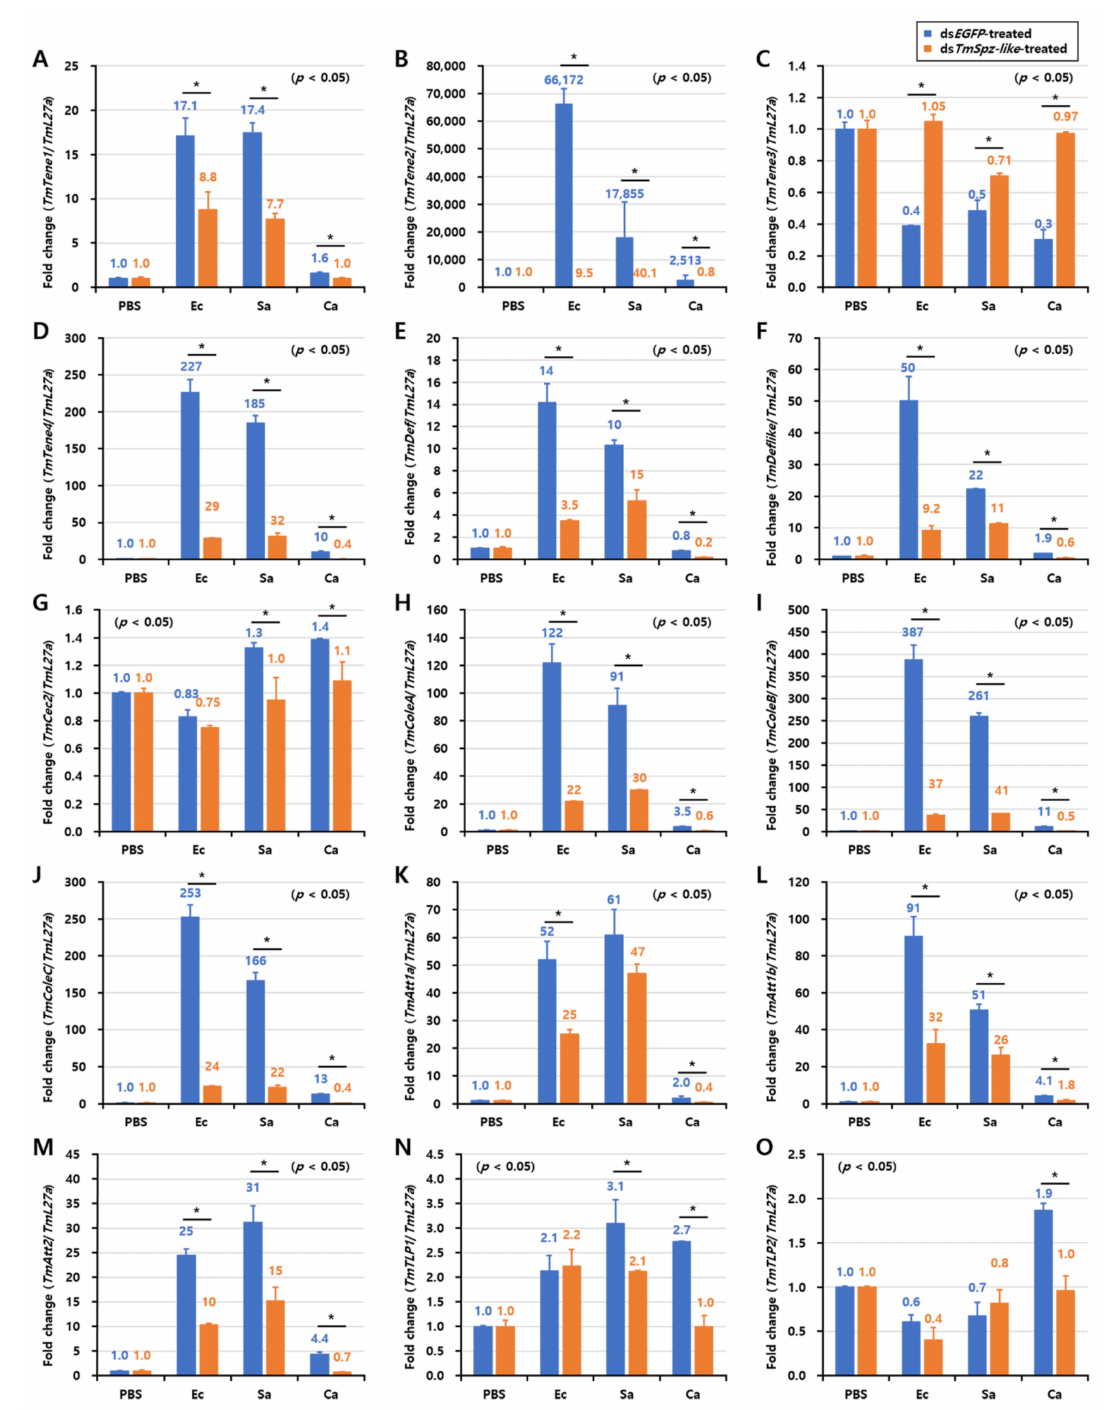
Figure 6. Antimicrobial peptide (AMP)-encoding mRNA expression patterns in whole body of TmSpz-like knockdown larvae in response to Escherichia coli, Staphylococcus aureus , and Candida albicans infections. Phosphate-buffered saline (PBS) was injected as a control at day 4 post- TmSpz-like knockdown. At 6 h post-microbial challenge, the expression levels of AMP-encoding genes, including TmTene1 ( A ), TmTene2 ( B ), TmTene3 ( C ), TmTene4 ( D ), TmDef ( E ), TmDef-like ( F ), TmCec2 ( G ), TmColeA ( H ), TmColeB ( I ), TmColeC ( J ), TmAtt1a ( K ), TmAtt1b ( L ), TmAtt2 ( M ), TmTLP1 ( N ), and TmTLP2 ( O ), were measured using quantitative real-time polymerase chain reaction. ds EGFP was injected as a negative control. TmL27a expression was measured as an internal control. The number above the bars represents the AMP transcriptional levels. The experiments were performed in biological triplicates. Asterisks indicate significant differences between ds TmSpz-like - and ds EGFP -injected groups (Student’s t -test; * p <